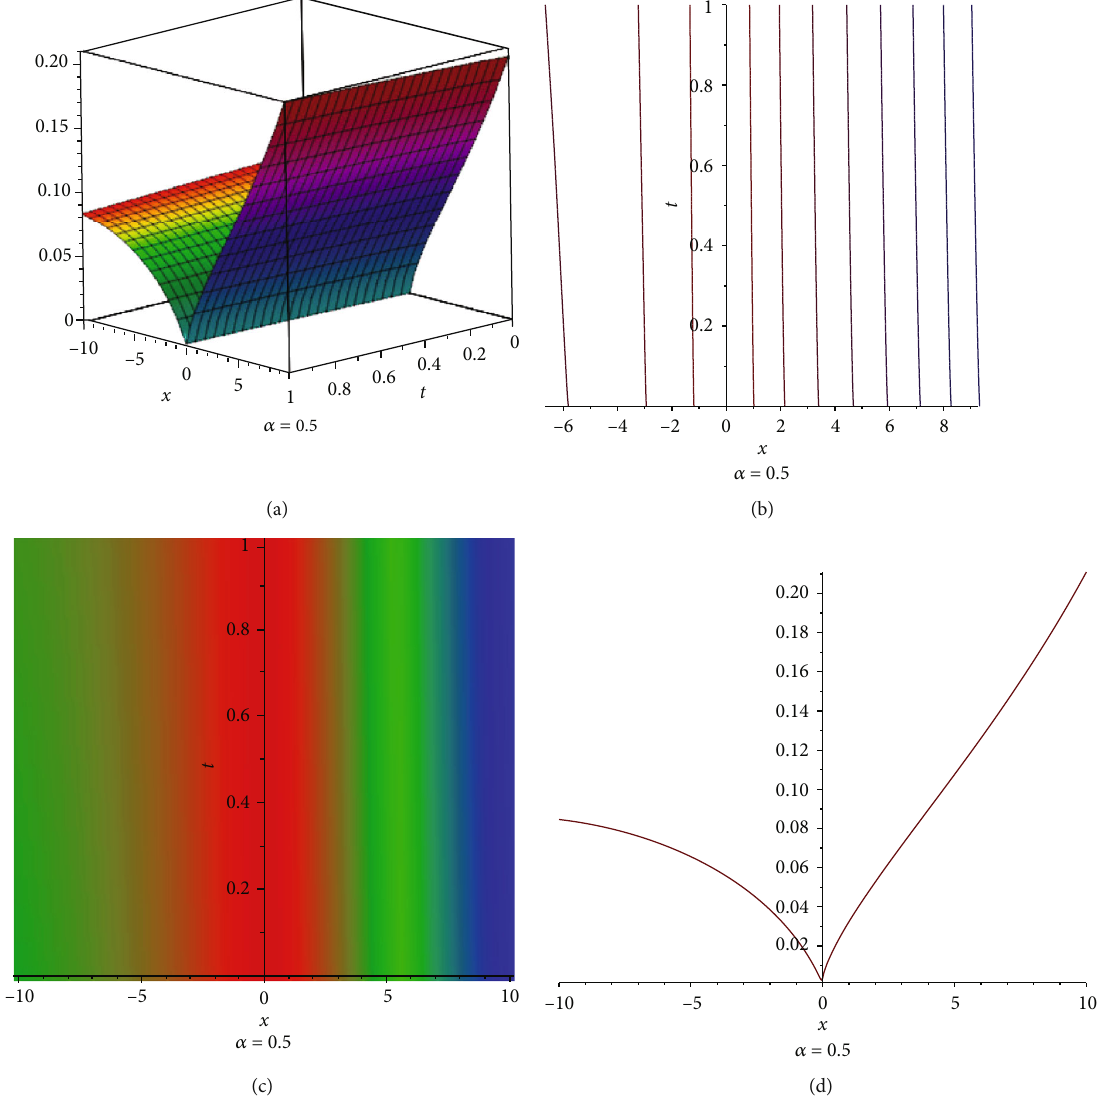
= 0 : 63, δ = δ = w = w = 1 2 3 1 2